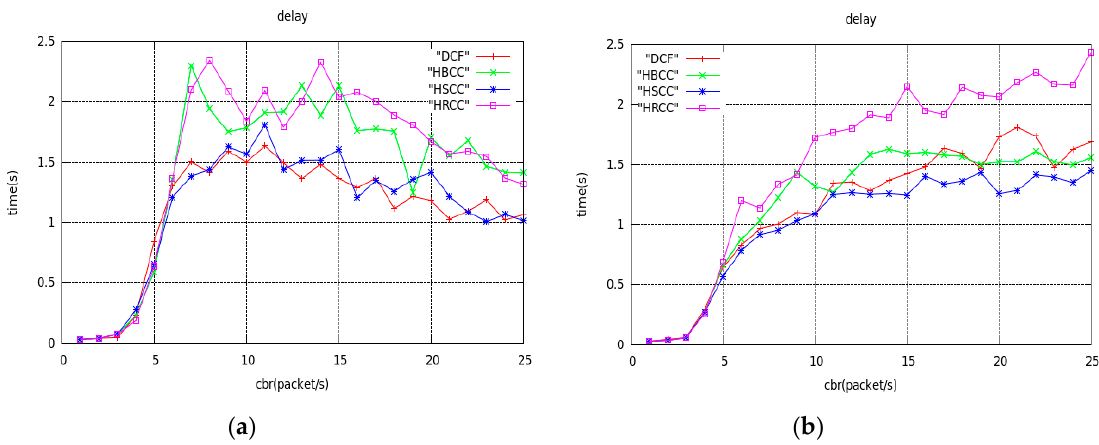
Figure 17. Average end-to-end delay curves of random network topology. ( a ) The topology of Figure 14a; ( b ) The topology of Figure 14b.